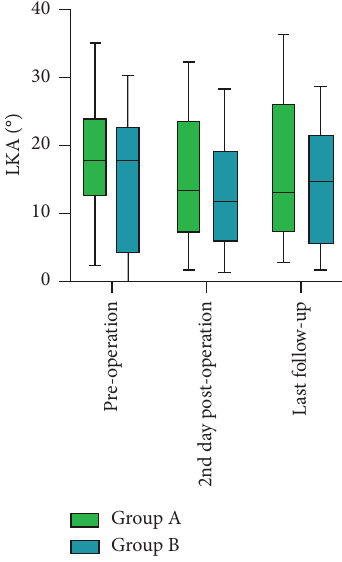
Figure 5: IVH (mm) between the groups. Figure 6: LKA ( ° ) between the